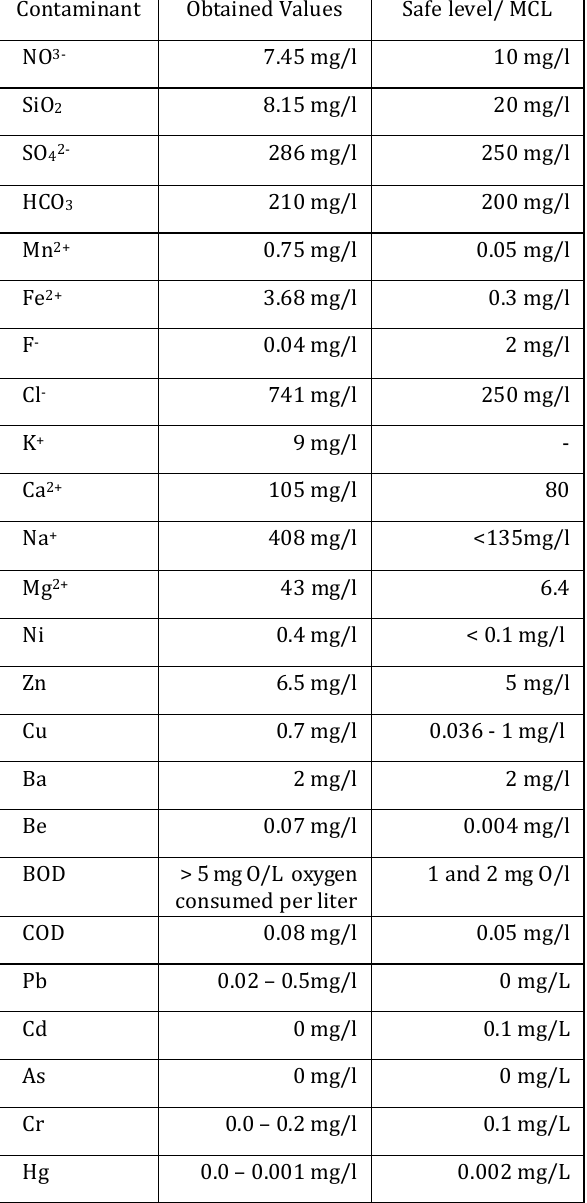
Table 2. Chemical analysis of groundwater